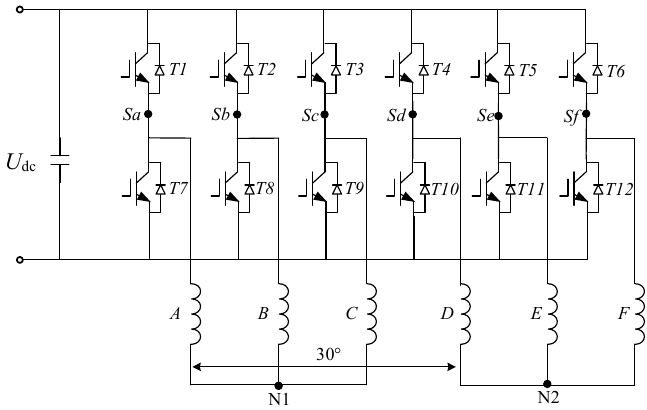
Figure 1. Topology of the six-phase inverter with neutral isolation.